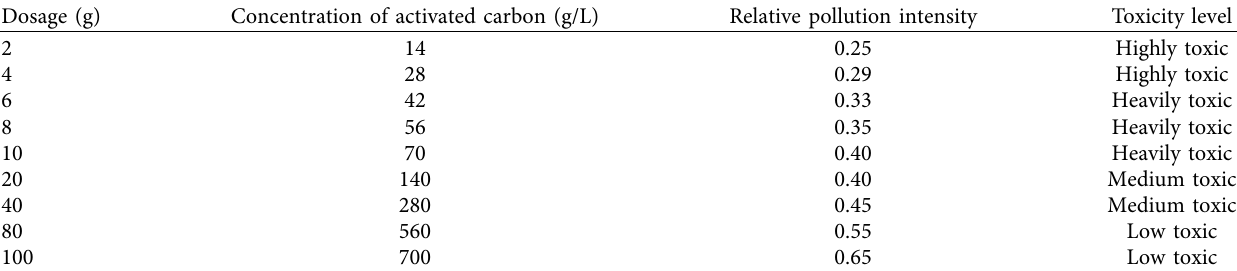
Table 5: Samples with different dosages of molecular toxicity of sudden ecological environmental pollution.